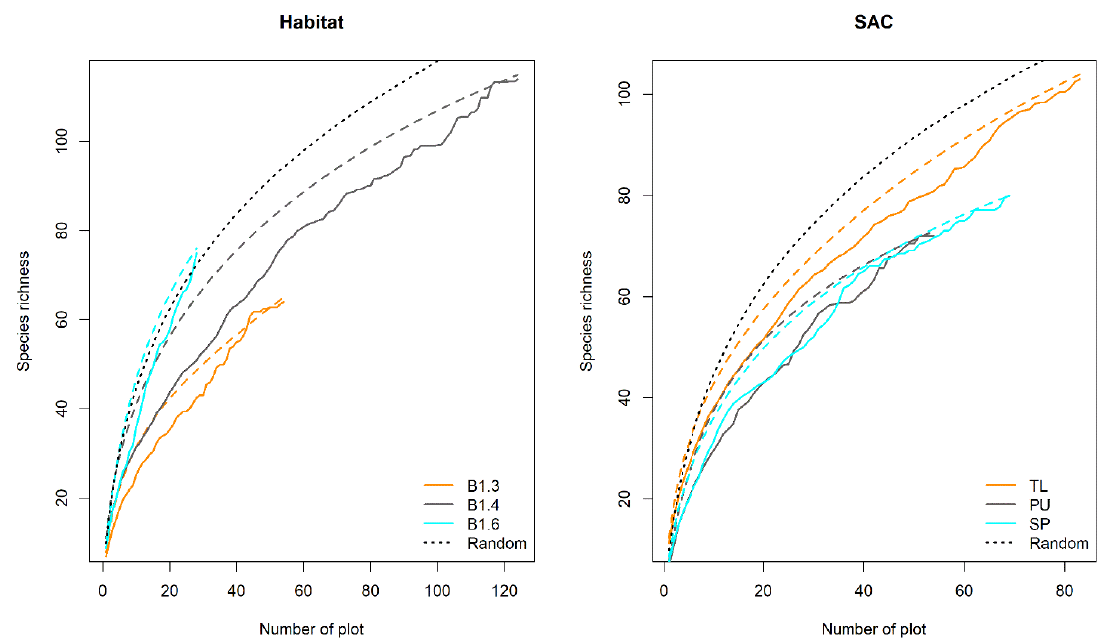
Figure 2. Spatially-explicit rarefaction curves (SERs, solid lines) and plot-based rarefaction curves (RCs, dashed lines) calculated among habitats (left) and SACs (right). The dotted line (Random) represents the RC calculated from the whole species pool. Please note that this curve was truncated according to the maximum number of plots detected in each factor. TL = Torre del Lago; PU = Parco Uccelllina; SV = Selva Pisana.